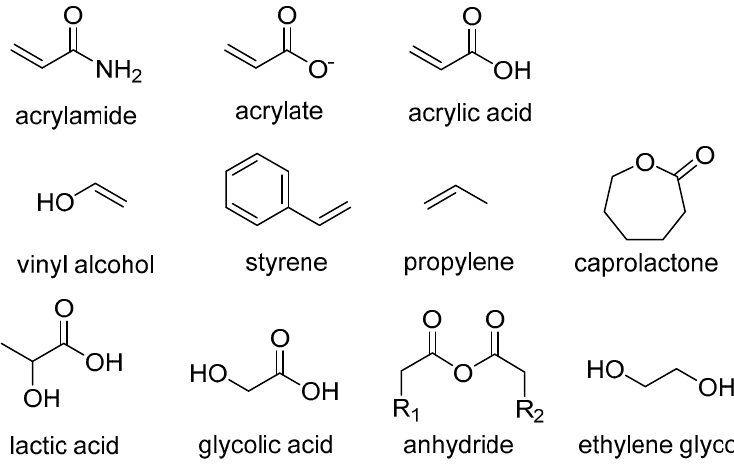
Figure 2. Basic unit of polymers used for polymeric